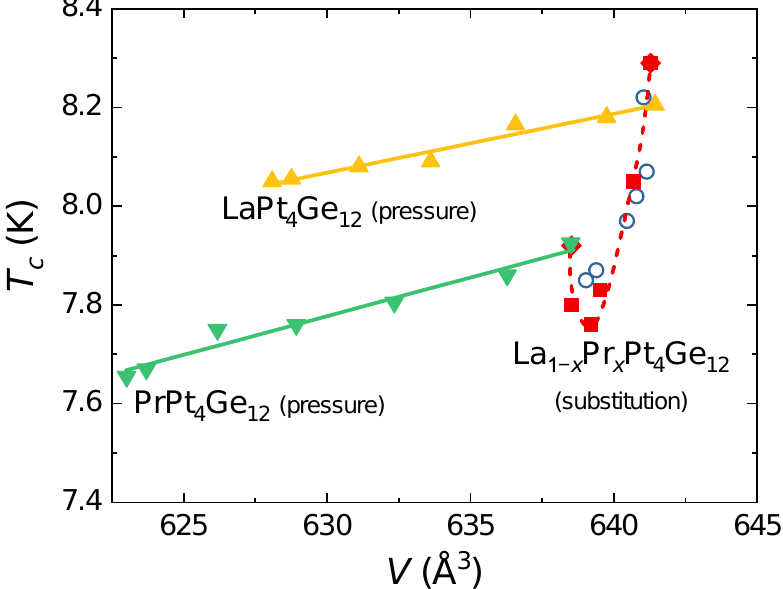
Figure 4. Superconducting temperature—unit-cell volume phase diagram of pressurized LaPt 4 Ge 12 and PrPt 4 Ge 12 combined with data of the substitution series La 1 − x Pr x Pt 4 Ge 12 . The open blue symbols correspond to data determined from specific heat [25], while the solid red diamonds [3] and the solid red squares [12] represent our previously published data based on magnetic susceptibility measurements taken in a magnetic field of µ 0 H = 2 mT. The straight lines are fits to the data and the red dashed line is a guide to the